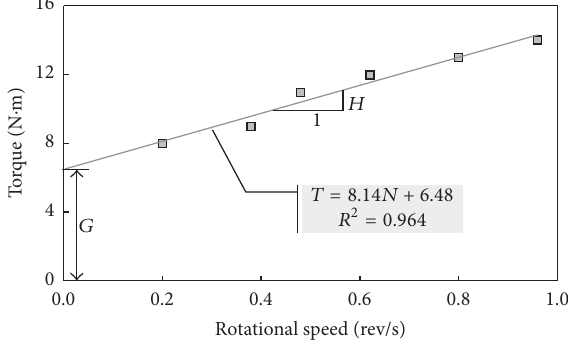
Figure 2: Typical data obtained from the IBB rheometer.